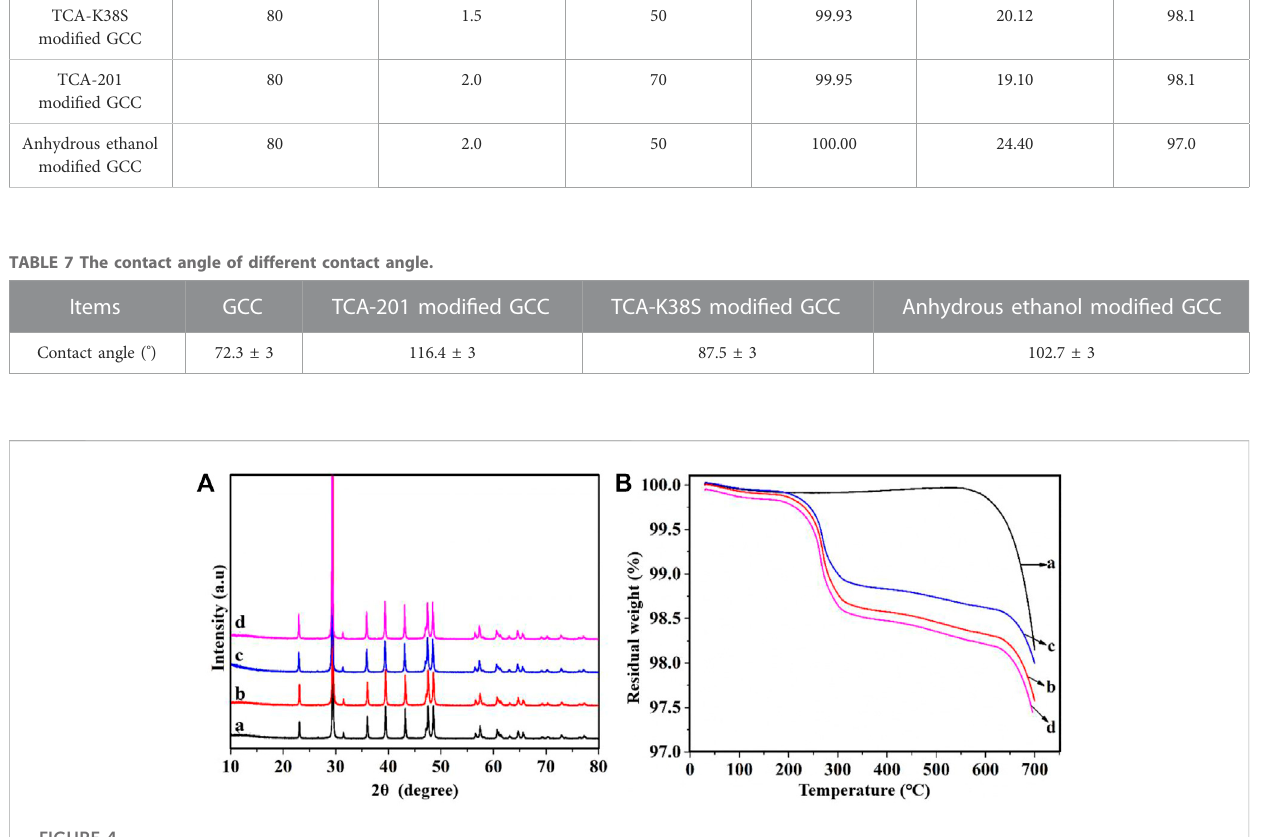
FIGURE 4 Modi fi ed GCC (A) XRD spectrum and (B) TG-DTA, a: Unmodi fi ed GCC, b: TCA-201 modi fi ed GCC, c: TCA-K38S modi fi ed GCC, d: sodium stearate modi fi ed